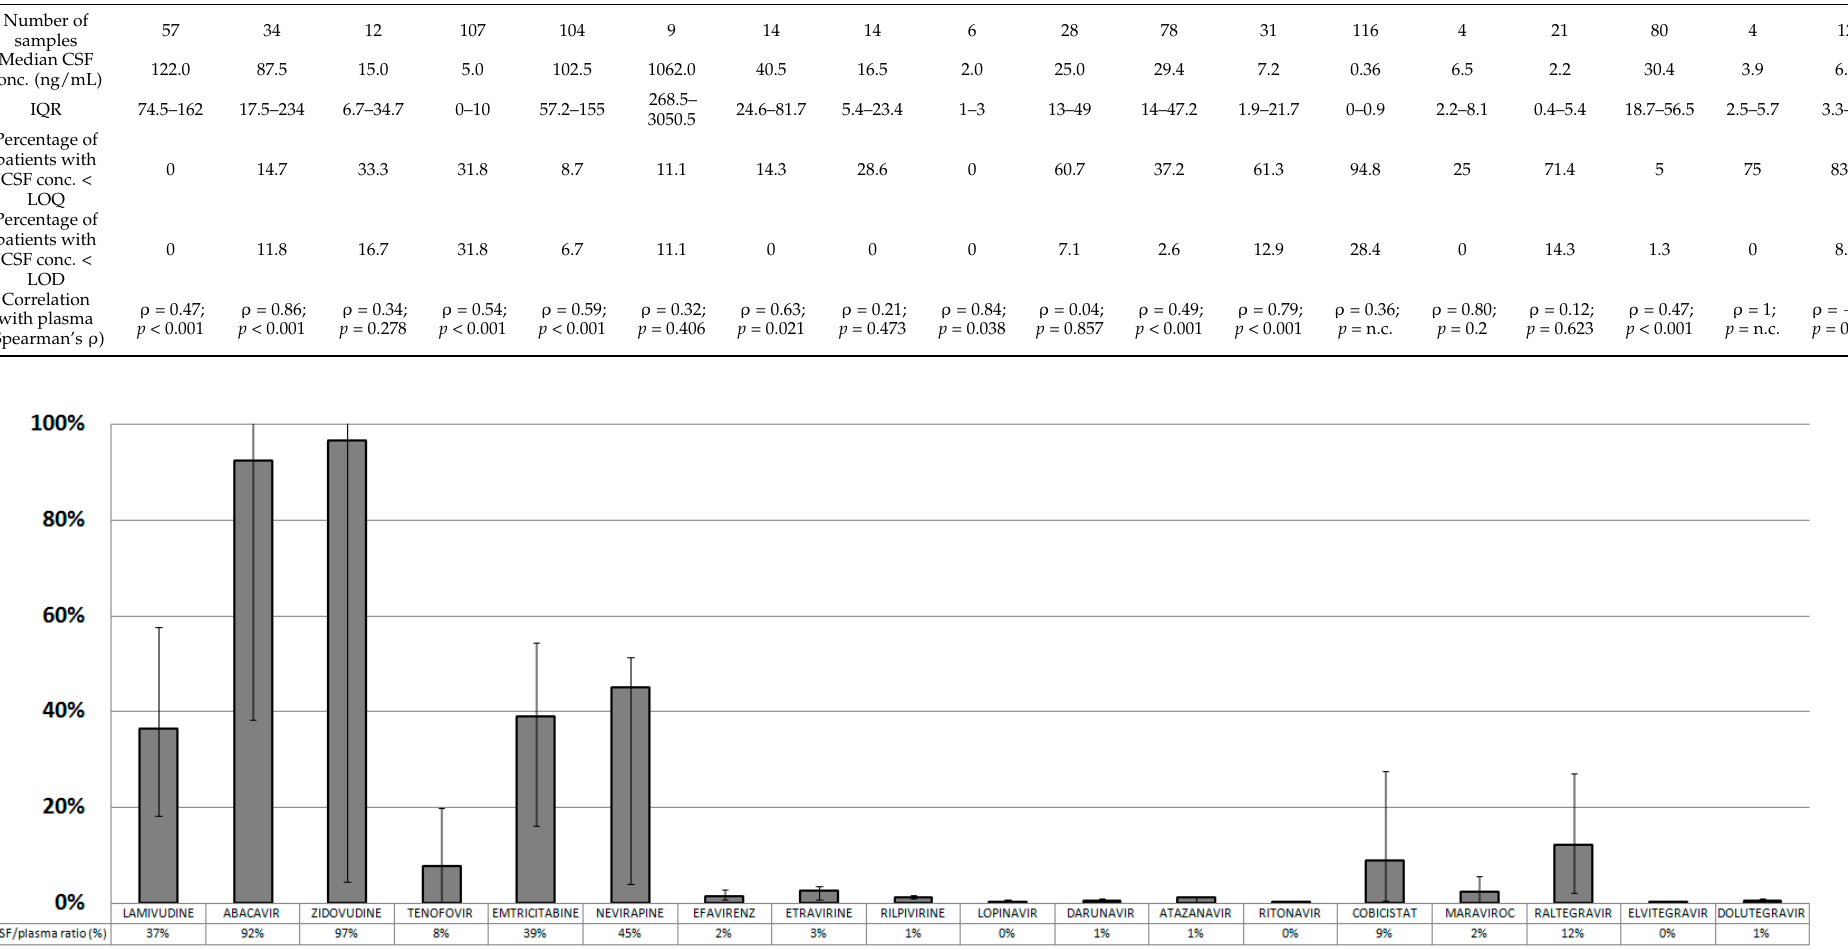
Figure 2. Cerebrospinal fluid/plasma ratio of different antiretroviral drugs.